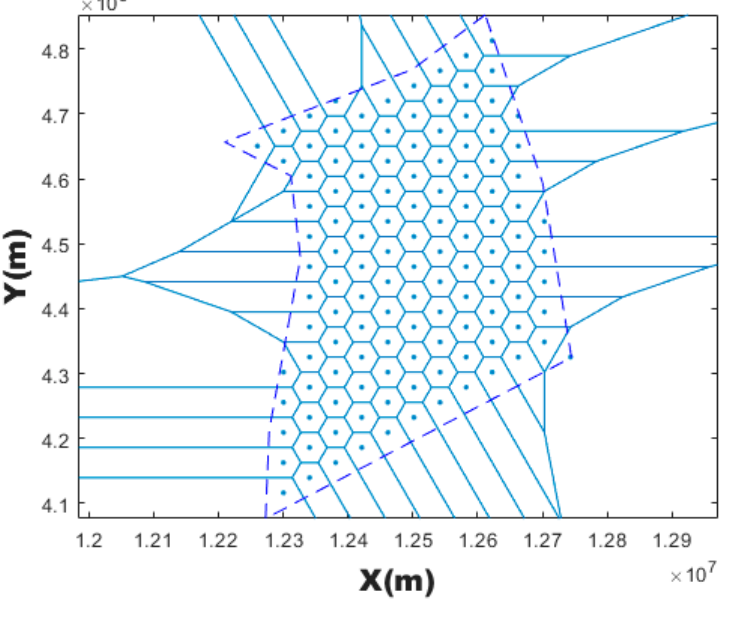
Figure 5. Hexagonal seed. Figure 5. Hexagonal